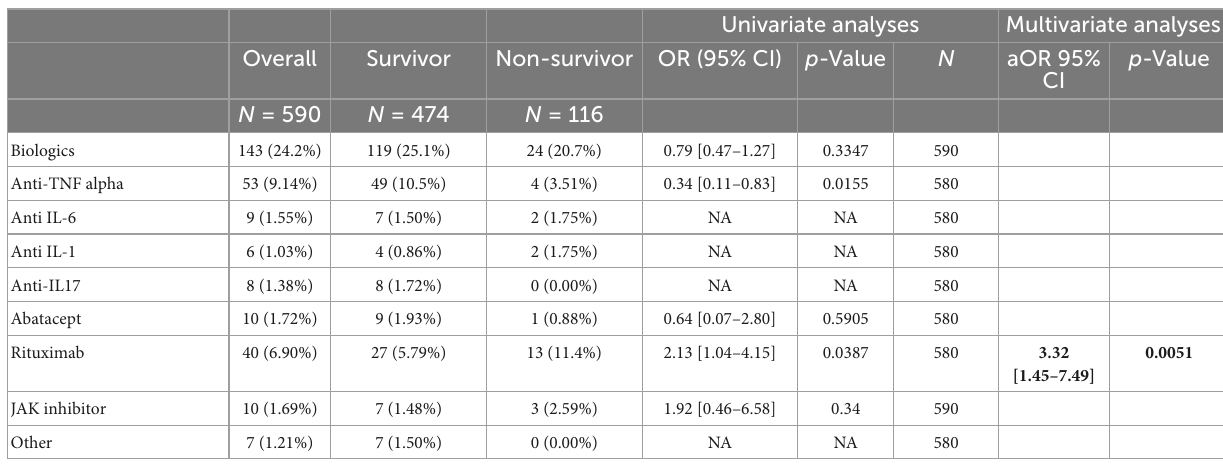
TABLE 4 Odds of severe COVID-19: Comparison between patients with or without AIRDs: case–control study within EDS database. Before PS matching After PS matching AIRD